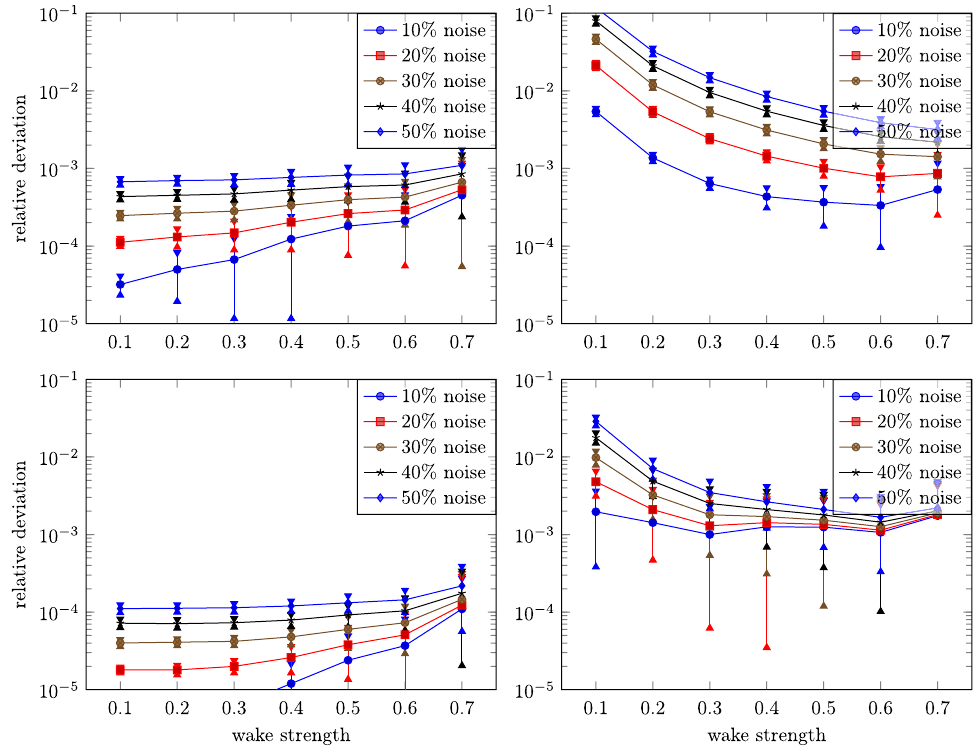
FIG. 2. Relative differences between the temporal vectors or the spatial vectors of the extracted betatron mode or the wake mode and the original ones. Upper left: ð u 1 − K Þ =K ; upper right: jð v 1 − A Þ =A j ; lower left: jð u 2 − L Þ =L j ; lower right: ð v 2 − B Þ =B . The abscissa is b=a , meaning the ratio of the amplitude of the wake oscillation to the amplitude of the betatron oscillation. Different lines had different noise levels c=a contributed to the